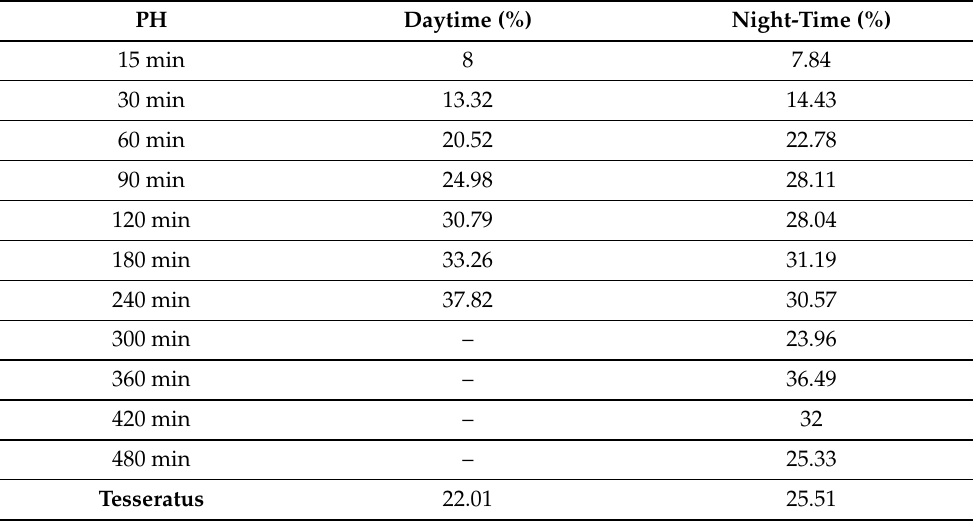
Table 10. Mean Absolut Percentage Error (MAPE)—daytime and nighttime comparison of PH concerning seven T1D individuals. General average MAPE at daytime and nighttime for